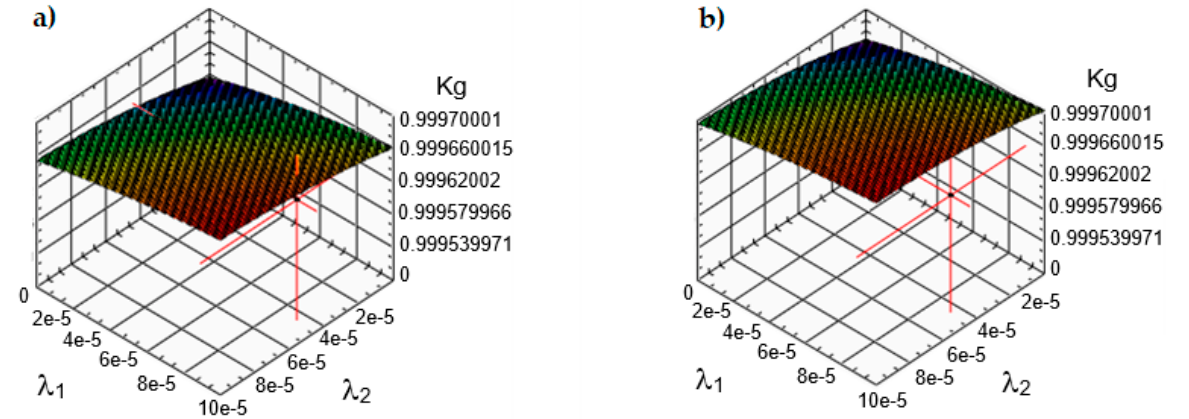
Figure 11. Graphs of the test of the mean time between successive failures, for constant parameters,